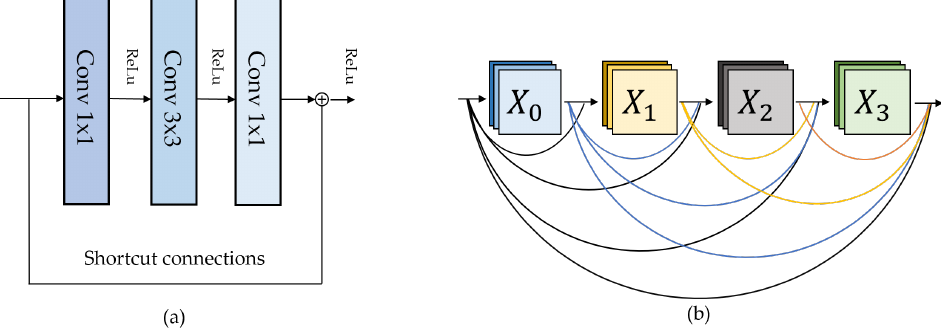
Figure 5. Building blocks of ResNet and DenseNet: ( a ) Bottleneck building block for ResNet 50/101/152 where the 1 × 1 layers reduce and increase dimensions, and 3 × 3 layer extracts features; ( b ) Simple dense block of DenseNet. The multiple dense blocks are connected with the transition layers and compose the